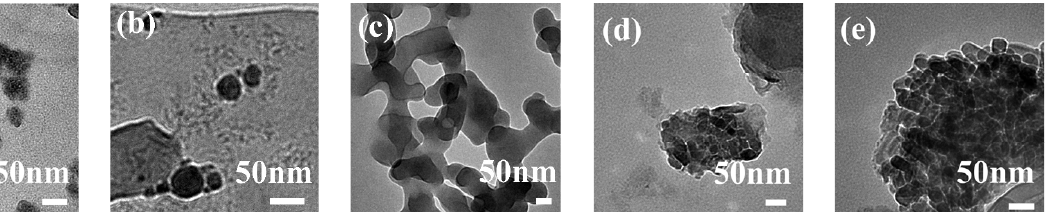
Figure 4. TEM images PA11/SiO 2 composite, ( a ) SiO 2 , ( b ) PA11/0.5% SiO 2 , ( c ) PA11/1.0% SiO 2 , ( d ) PA11/1.5% SiO 2 , ( e ) PA11/2.0% SiO 2.